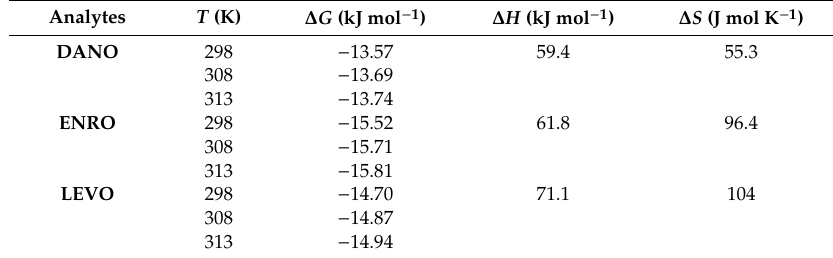
Table 6. Thermodynamic parameters for DANO, ENRO and LEVO sorption on MMPC / Cyc-Chit.